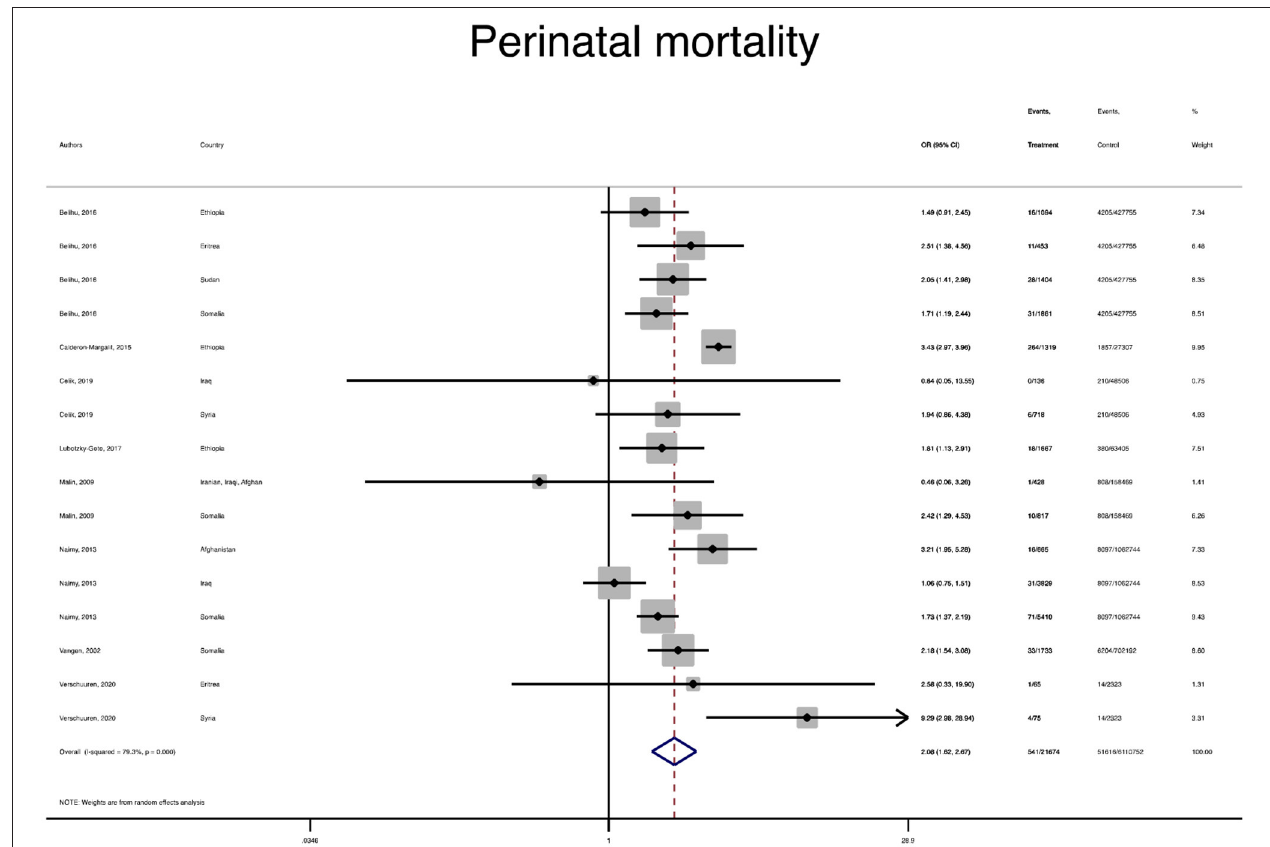
FIGURE 5 | A forest plot of the pooled odds ratio of perinatal mortality in the immigrant and native-origin populations.